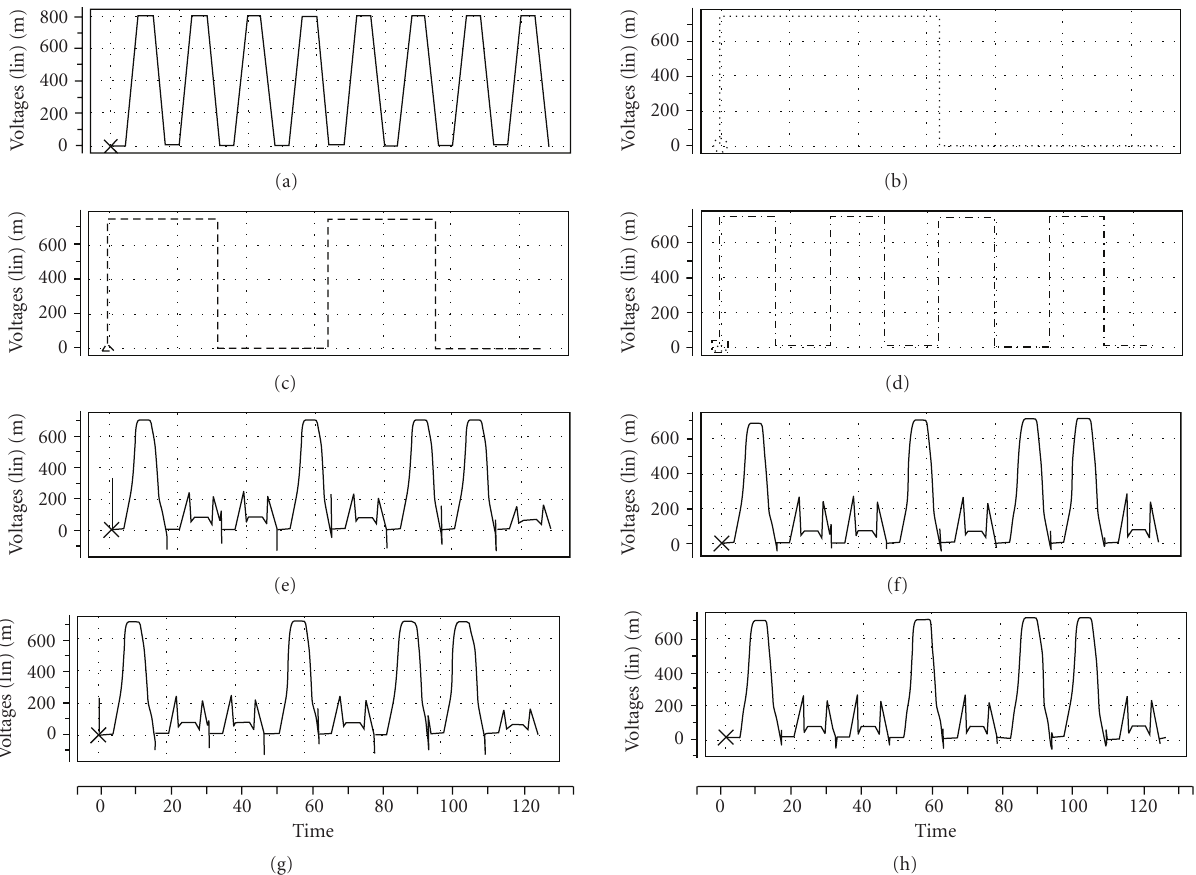
Figure 2: The simulation results for proposed XOR gate circuits. (a) The clock ( V bias = 0 . 8). (b), (c), and (d) are the three input waveform which are V HIGH = 0 . 75 V and V LOW = 0. (e) The output result for the proposed GTG-2 XOR. (f) The output result for the proposed GTG-3 XOR. (g) The output result for the proposed GTG-4 (modified GTG-2) XOR. (h) The output result for the proposed GTG-5 (modified GTG-3)